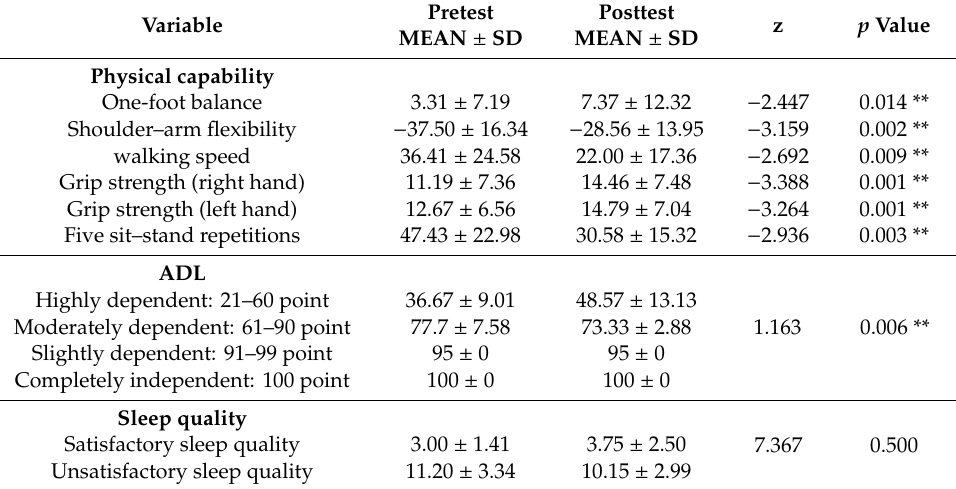
Table 1. Pretest and posttest results regarding participants’ physical capability, ADL, and sleep quality ( n =